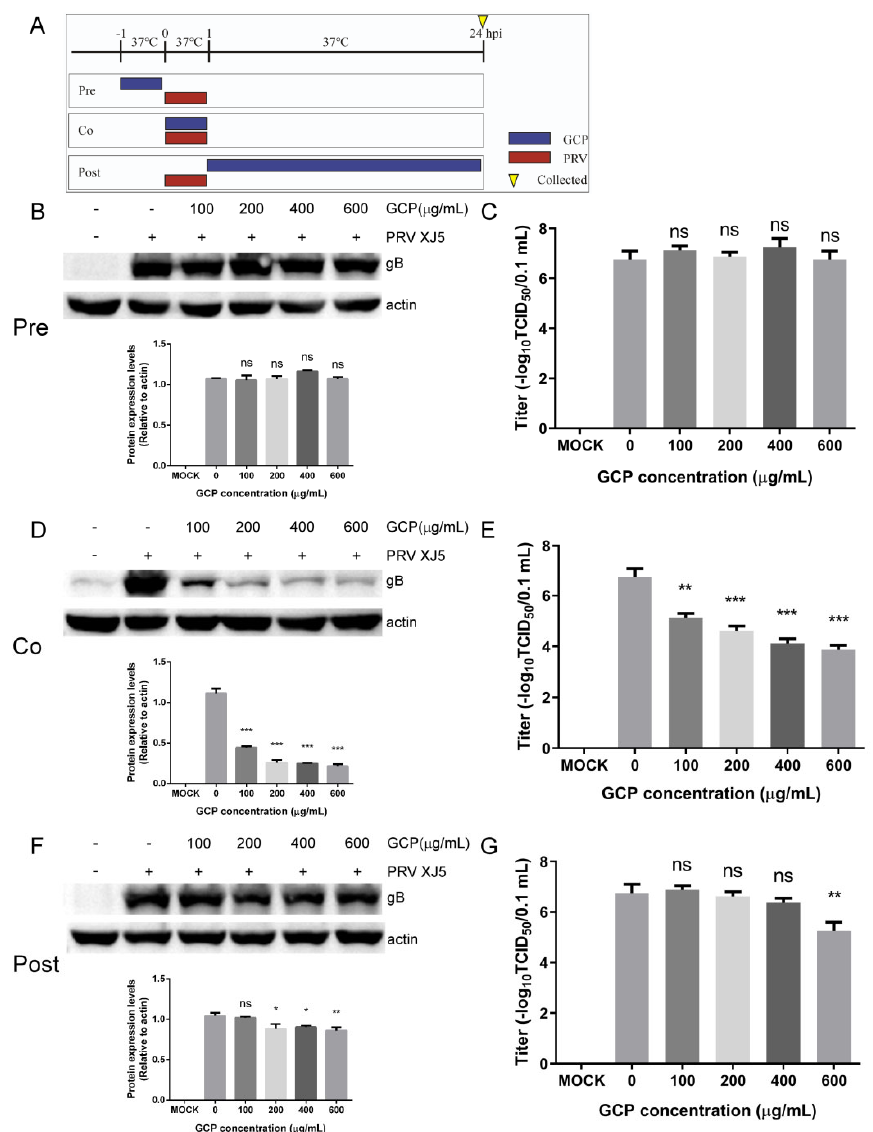
Figure 4. GCP inhibited the early stages of PRV infection. ( A ) Schematic diagram of GCP admin- istration. PK-15 cells were infected with PRV XJ5 (MOI = 0.1) for 1 h and cells were treated with GCP at different hpi, designated pre—treatment (pre), co—treatment (co), or post—treatment (post). ( B , C ) Western blot for detection of gB expression and TCID 50 for detection of viral titer after pre- treatment with GCP. ( D , E ) Western blot for detection of gB expression and TCID 50 for detection of viral titer after co—treatment with GCP. ( F , G ) Western blot for detection of gB expression and TCID 50 for detection of viral titer after post—treatment with GCP. All results were obtained from three independent experiments and were presented in means ± SD (ns, not significant; * p < 0.05; ** p < 0.01; *** p <